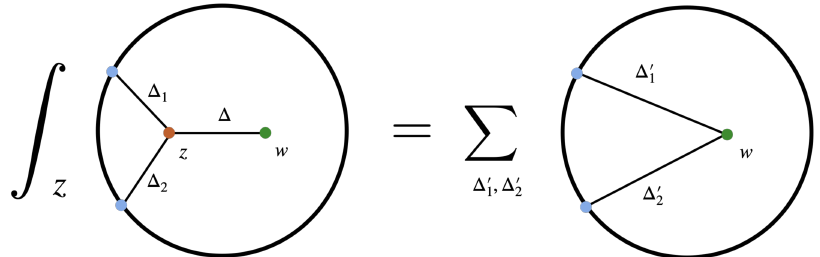
Figure 3 . An illustration of the integrated vertex identities. After integrating out the scalar bulk-to-bulk propagator, the part of the diagram with a cubic vertex can be written as a sum of contact